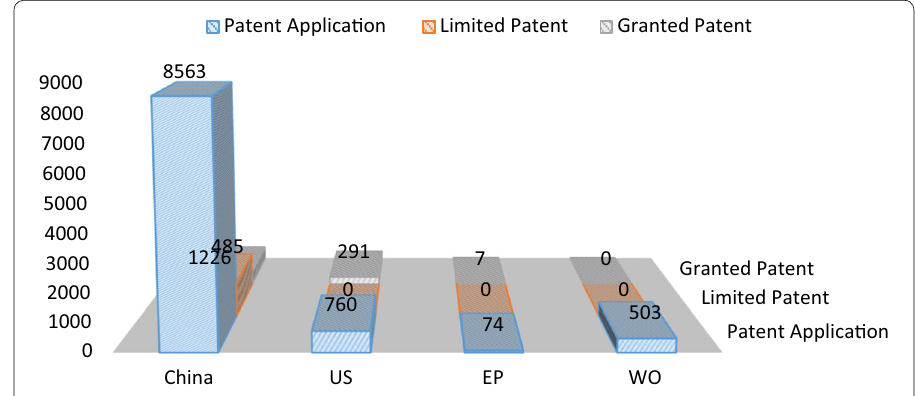
Fig. 7 Comparative analysis of granted patents in various